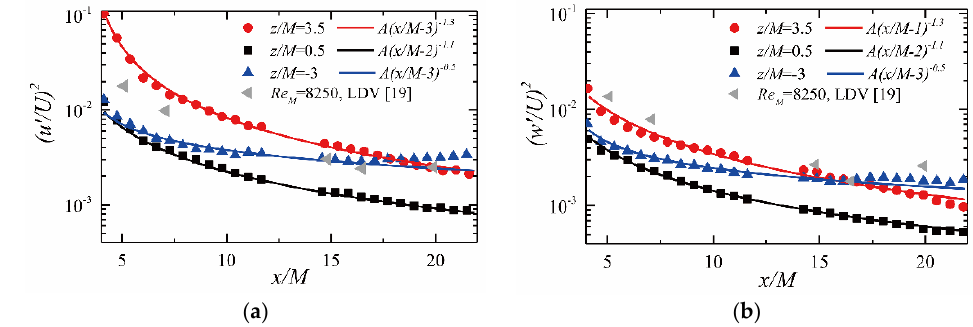
Figure 12. Stream-wise decay of turbulence intensities ( a ) stream-wise components ( u’ / U ); ( b ) vertical components ( w’ / U ); and the corresponding fitting results, red lines (at z / M = 3.5), black lines (at z / M = 0.5), blue lines (at z / M = − 3).